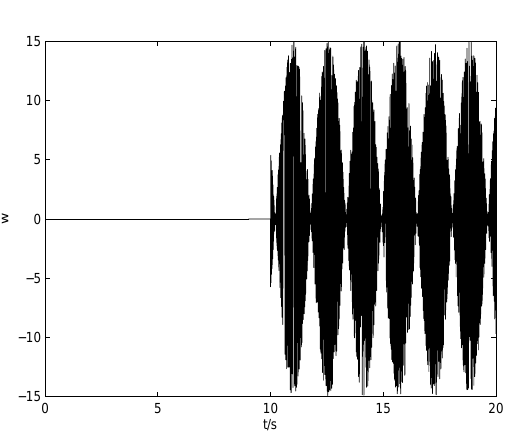
Figure 1: Time response of disturbance input of third order chaotic system